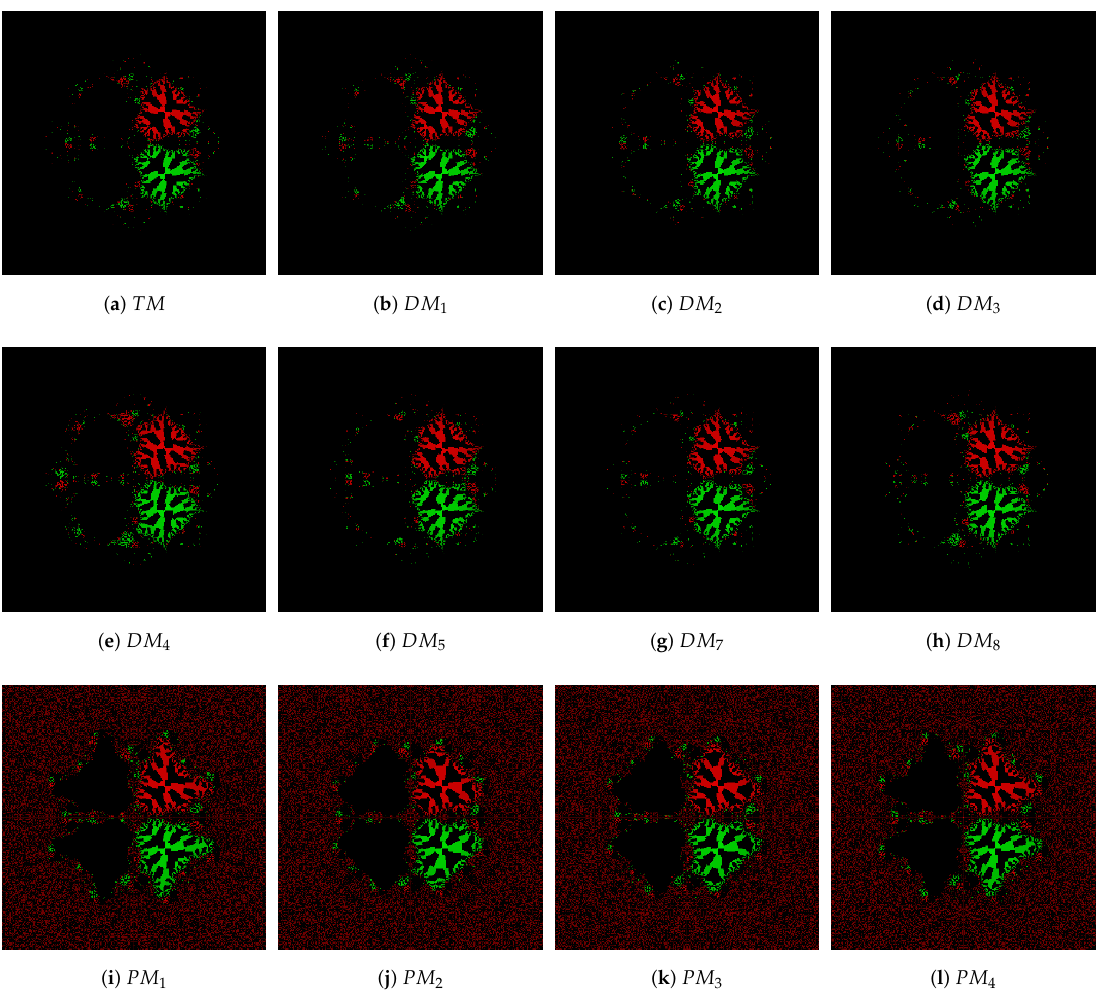
Figure 4. Comparisons of the convergence plane at β = − 0.01 for Problem 2 with m = 3.